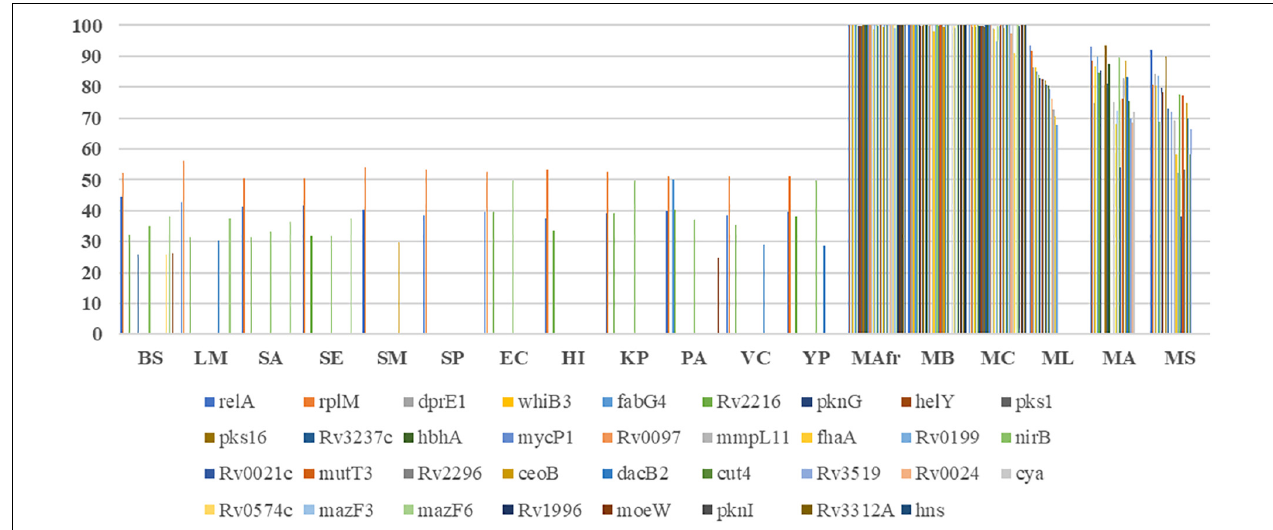
FIGURE 2 | Conservation of the curated biofilm and quorum sensing-associated genes. X -axis refers to the genome, and Y -axis represents the percent identity between the identified homologs, if detected.